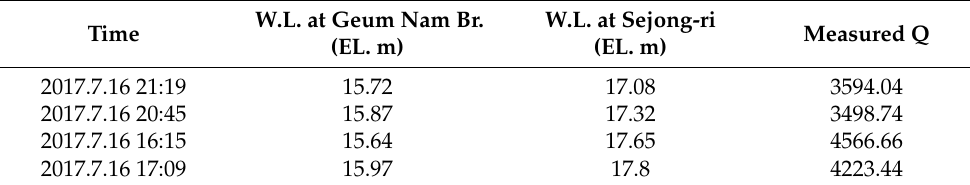
Figure 8. Comparison of hydrographs at the Sejong station. Table 3. Measured water level and discharge.